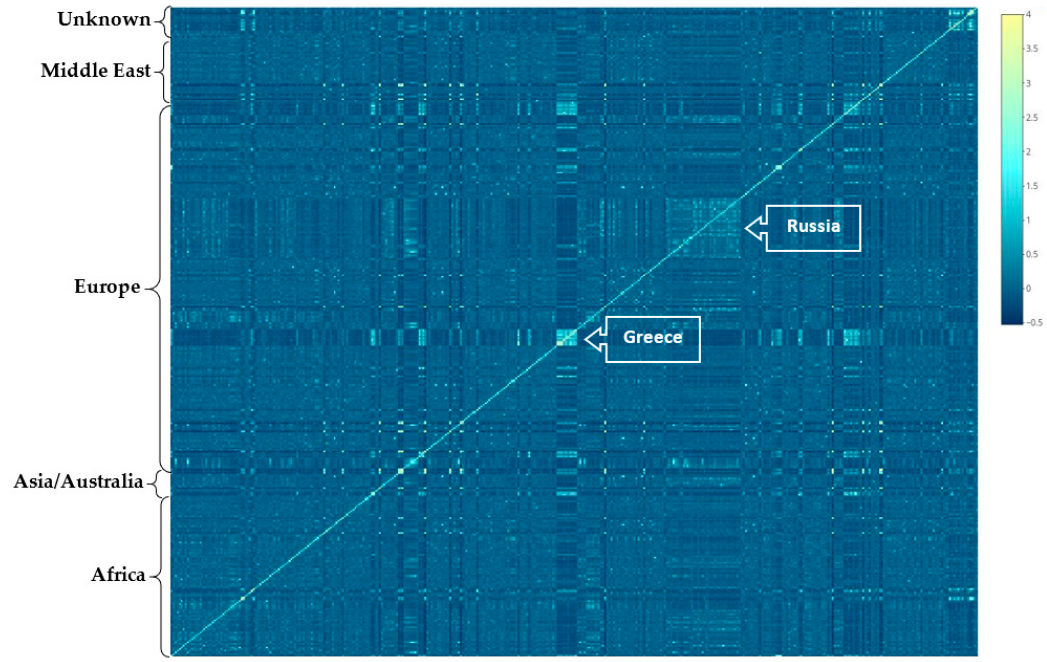
Figure 4. Heat map of the genomic relationship matrix ( G ) for tetraploid wheat accessions sorted by country of origin.